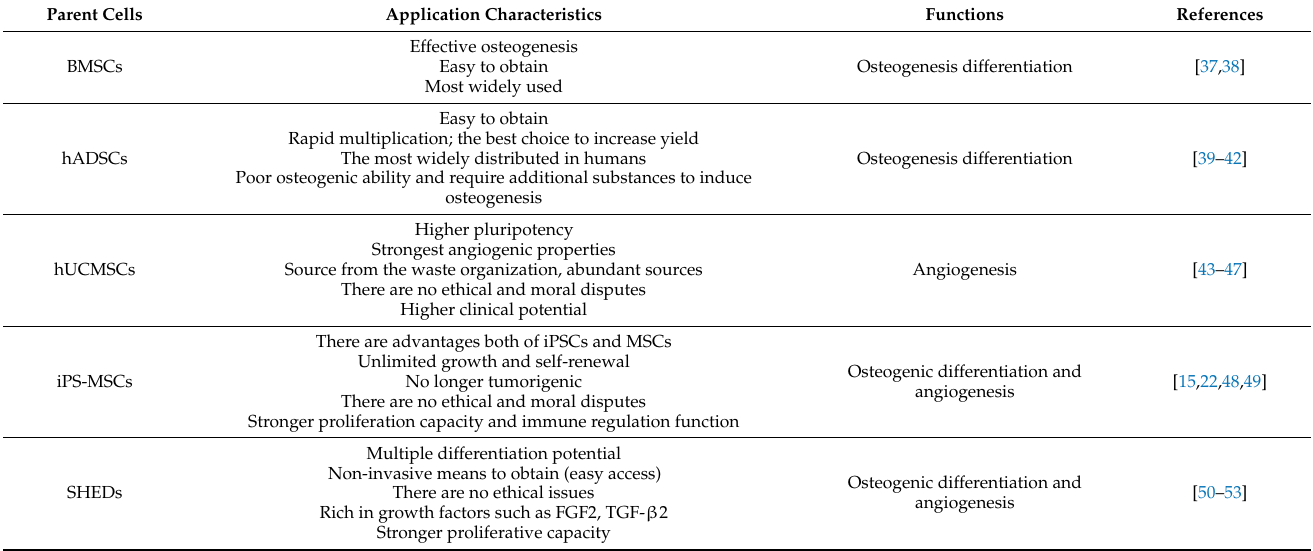
Table 1. Comparison of application characteristics and osteogenesis mechanism of common EVs parent